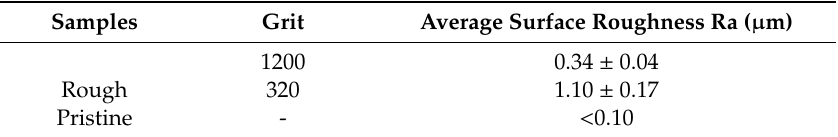
Table 2. Sandpaper grit size and the measured average surface roughness of the